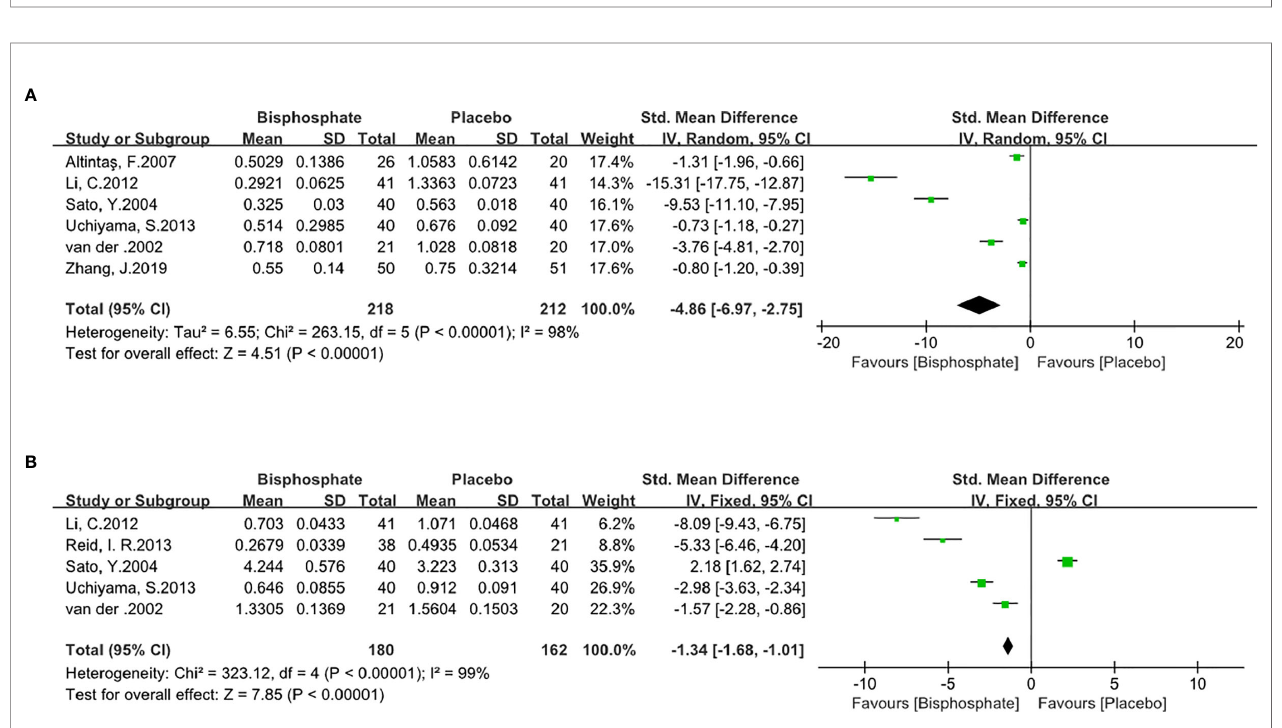
FIGURE 4 | Forest Plot of BMD changes between bisphosphonate and placebo.